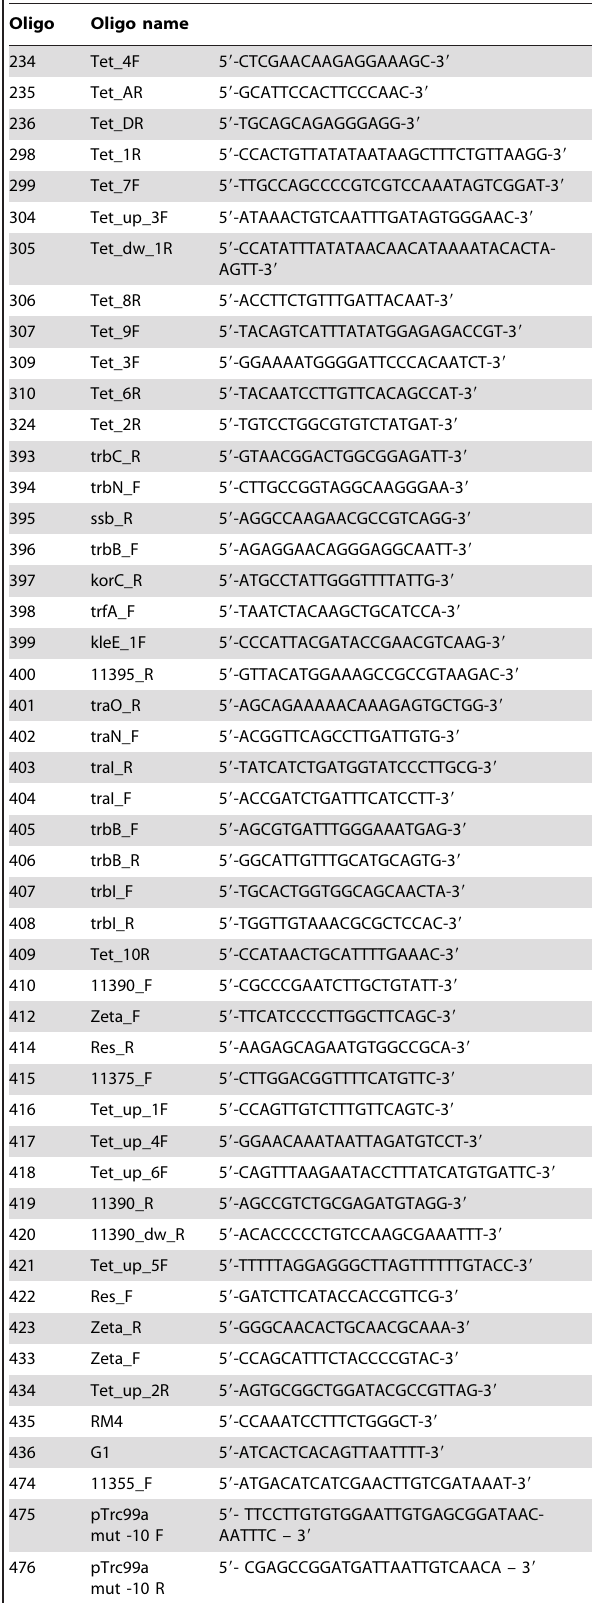
Table 5. Primers used in this